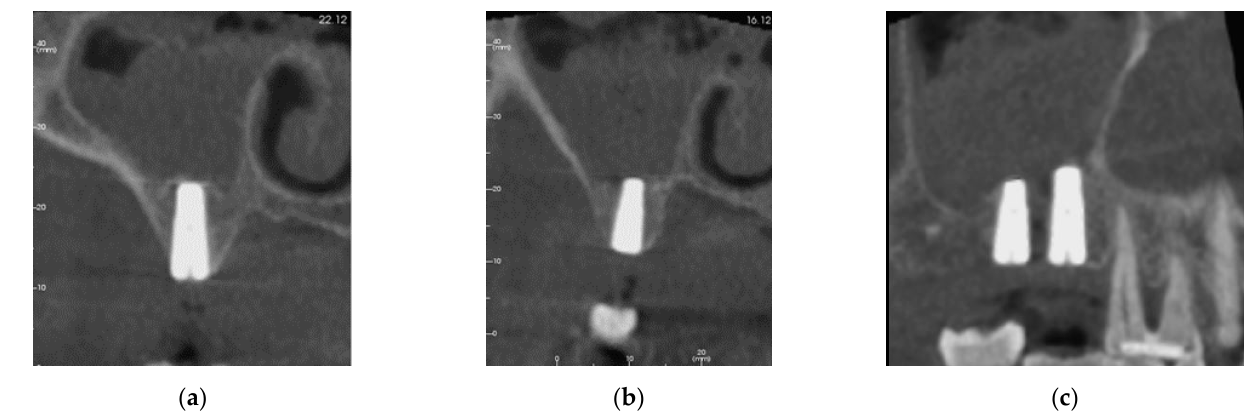
( c ) Figure 3. Patient #1. Immediately postoperative CBCT showing: ( a ) and ( b ) cross-section images of the surgical sites with regular “dome-shaped” membrane elevation and graft surrounding both implant apexes; ( c ) Panorex view highlighting a perforation in the distal apical portion of the elevated area, with arrows indicating biomaterial dispersed into the sinus cavity.